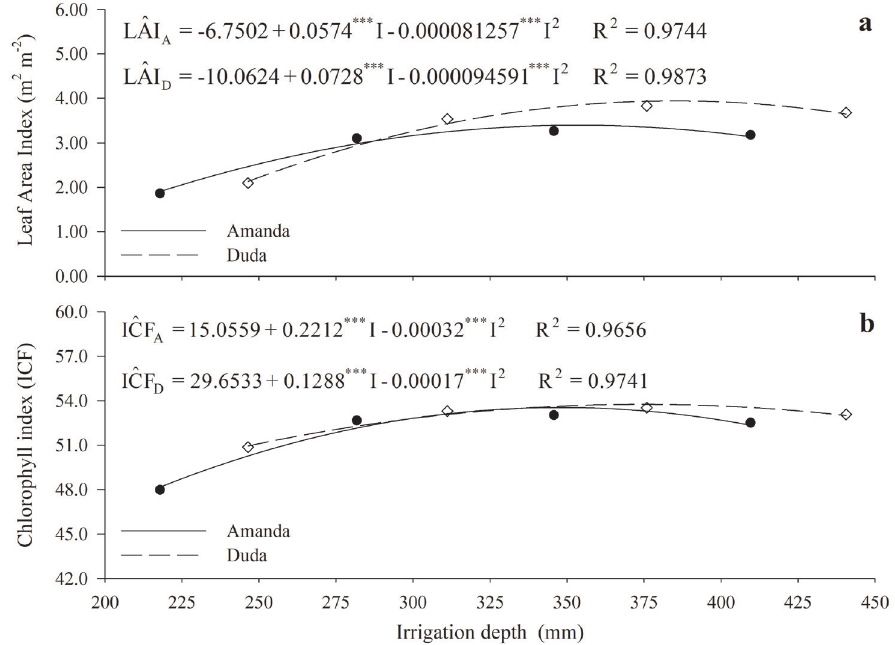
Figure 2 - Leaf area index (m 2 m -2 ) ( a ) and chlorophyll index (ICF) ( b ) of Amanda and Duda cultivars depending on irrigation depth.*** Significant at the 1% level of the “t” test. *** * Significant at the level of 1 to 5%, by “t” test.